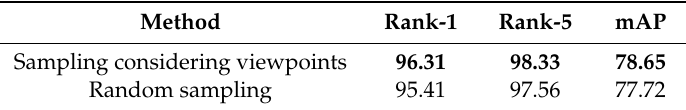
Table 4. Performance from di ff erent sampling strategies on the VeRi-776 dataset. The best performance is